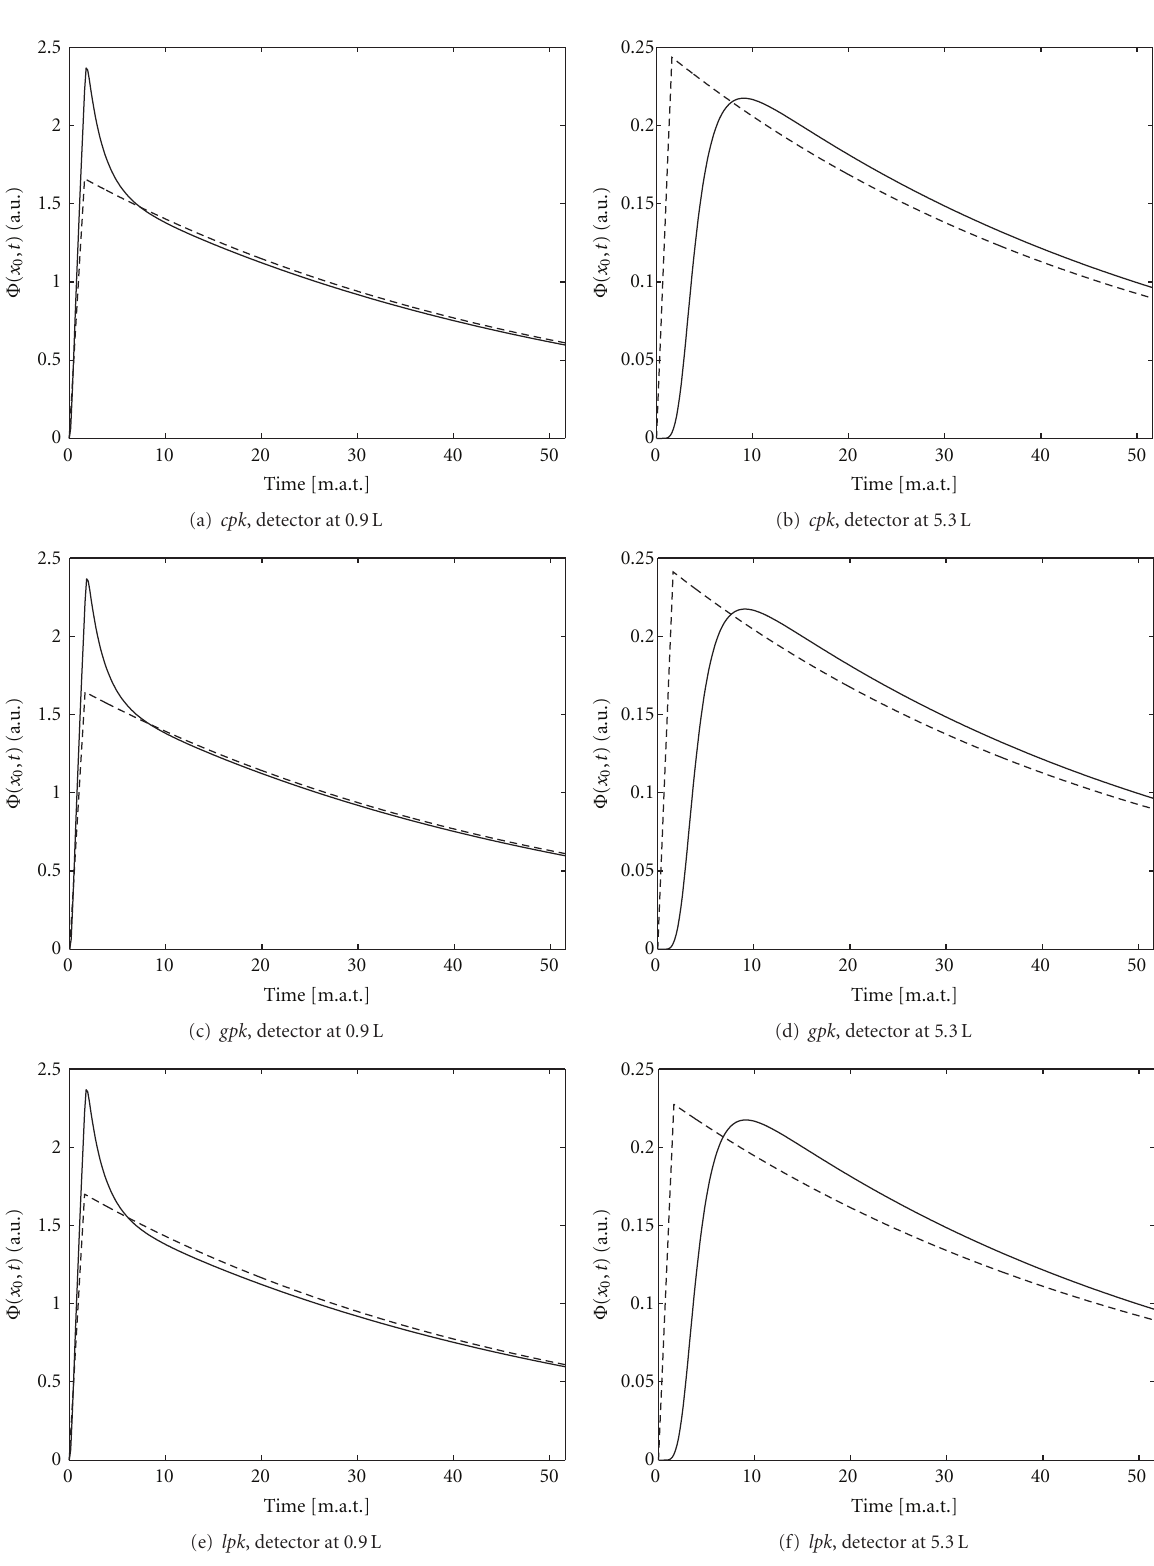
Figure 6: Evolution of the local flux following a source pulse in a subcritical system ( k e ff = 0 . 98) for two detectors, at x 0 = 0 . 9L (a, c, and e) and at x 0 = 5 . 3L (b, d, and f), adopting di ff erent formulations of the point kinetic model. Solid line: reference; dashed line: point